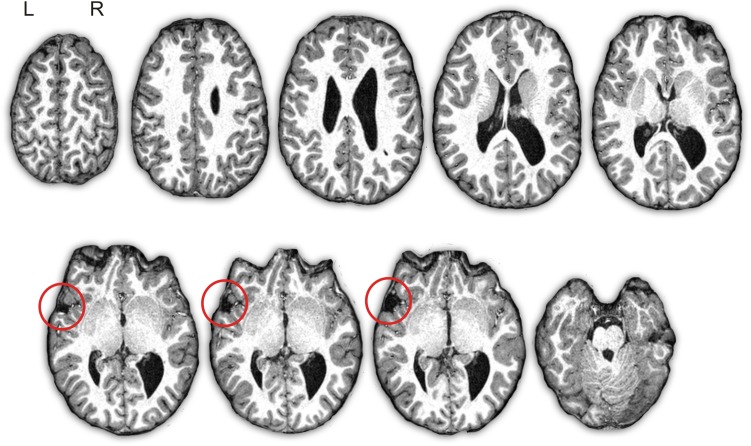
Depiction of subject D’s structural T1-weighted images. Axial slices of the brain in native space show the asymmetry of the volume of the lateral ventricles (right > left) with right occipital colpocephaly. There is an “open operculum sign” in the left hemisphere due to arrested development of the inferior frontal gyrus and superior temporal gyrus with exposure of the insular cortex (red circle). L, left; R, right.